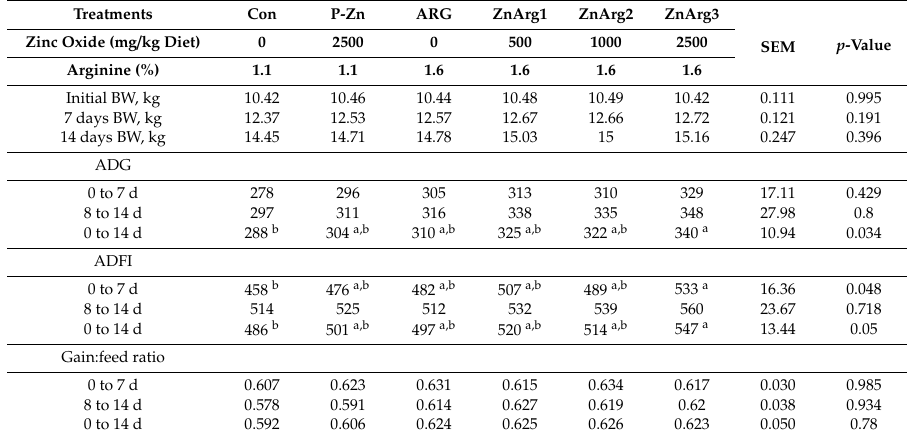
Table 3. E ff ect of dietary zinc and arginine on body weight (BW) average daily gain (ADG), average daily feed intake (ADFI), feed e ffi ciency (gain:feed) of weanling piglets exposed to high temperature. Treatments Con P-Zn ARG ZnArg1 ZnArg2 ZnArg3